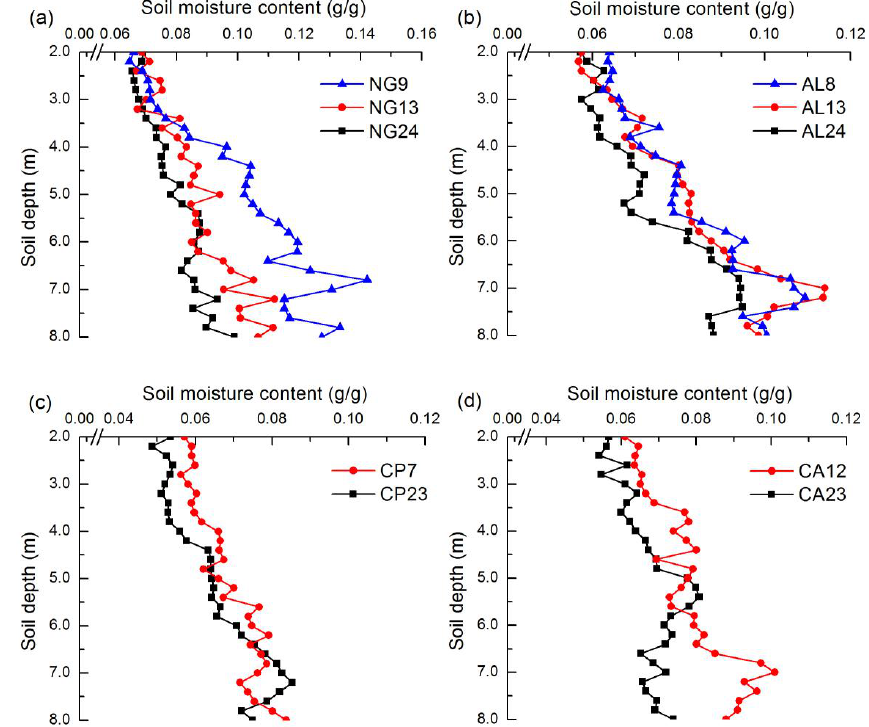
Fig. 7. Comparison of deep soil moisture content (SMC) in different slope gradients. Note: NG represents native grassland; AL represents alfalfa; CP represents Chinese red pine; CA represents Chinese arborvitae. The last number refers to slope gradient. For example, NG9 refers to native grassland with slope gradient of 9 ◦ , NG13 to natural grassland with slope gradient 13 ◦ , and NG24 to natural grassland with slope gradient 24 ◦